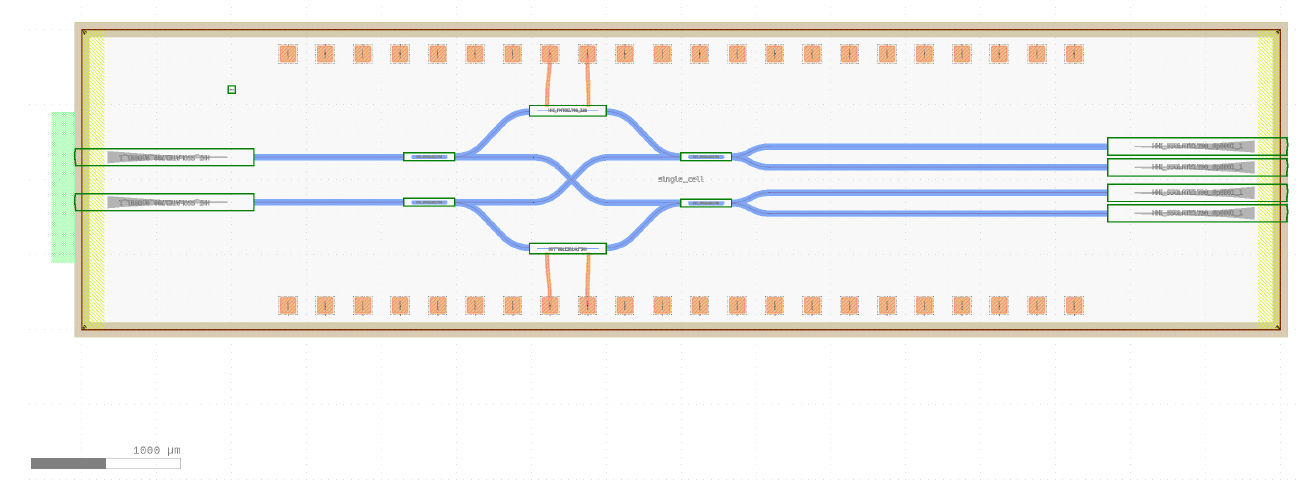
Figure 10. Design of a 8 × 2 mm photonic integrated circuit containing a 90 ◦